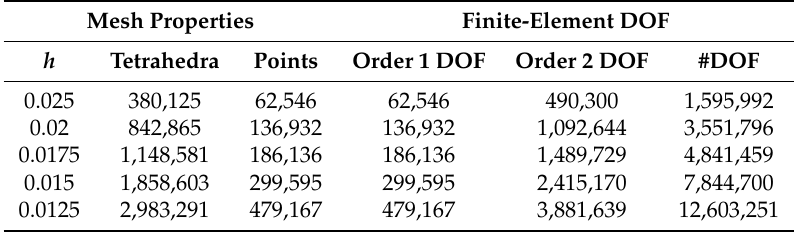
Table 2. Mesh properties and degrees of freedom: mesh characteristic size, number of tetrahedra, number of points, number of order 1 degrees of freedom, number of order 2 degrees of freedom and total number of degrees of freedom of the simulation.